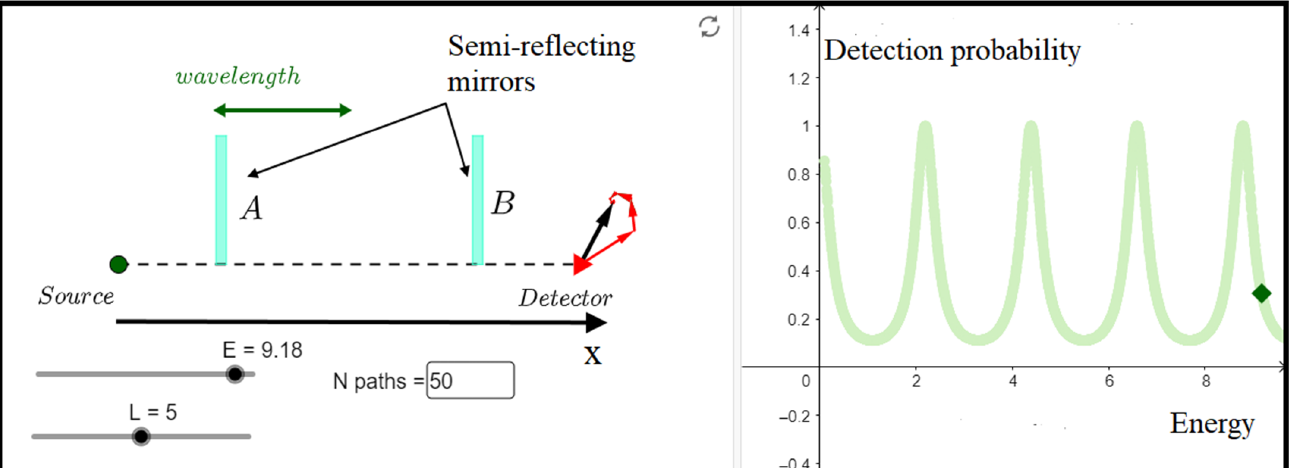
Figure 4. Partial snapshot of the simulation of resonant scattering between two semi-reflecting mirrors for a photon in the framework of the time-independent sum over paths approach. Left: the setup with the green dot representing the source and the red triangle the detector. The green arrow represents the wavelength of the photon directed towards a system of two semi-reflecting mirrors. Right: the probability of detecting the photon at the detector beyond the mirrors as a function of energy, displaying the typical equispaced resonances. The diamond shows the energy used in the simulation. The red arrows indicate the amplitudes associated to individual paths, which are summed to form the final amplitude (black